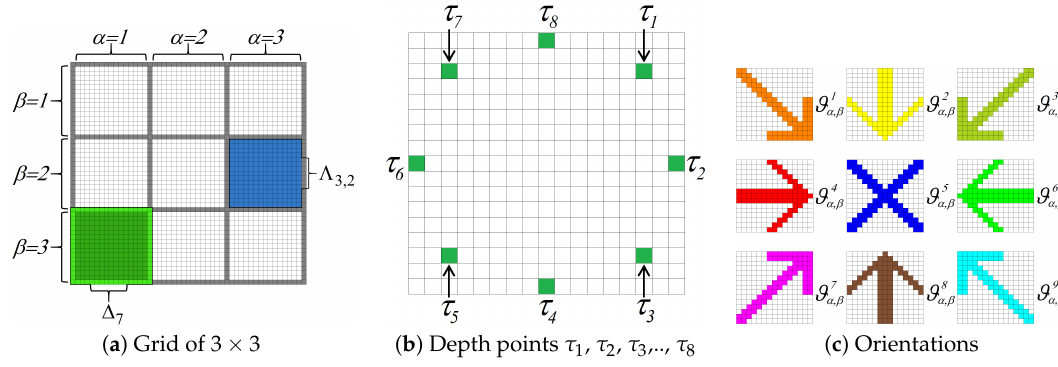
Figure 2. Depth analysis. Each image shows a step of the depth analysis.